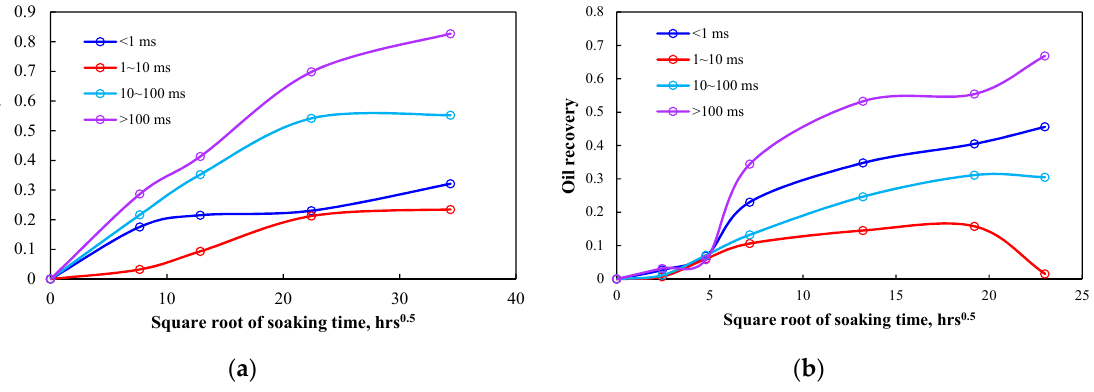
Figure 10. Oil recovery in different diameter pores: ( a ) UC7-2 and ( b ) LC7-2.